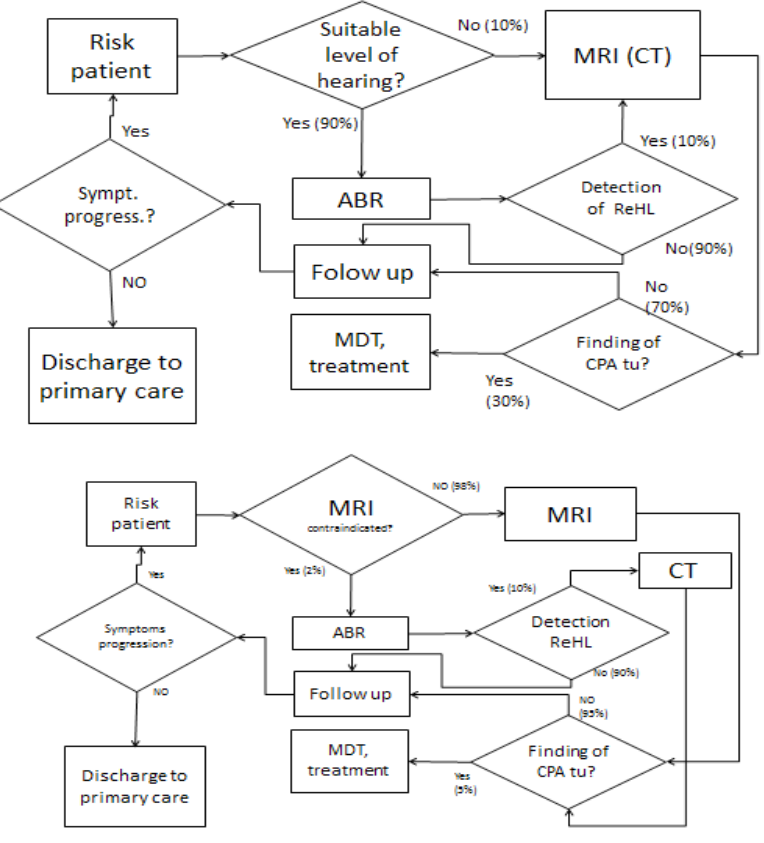
Fig. 1. Two forms of diagnostic algorithm for CPA